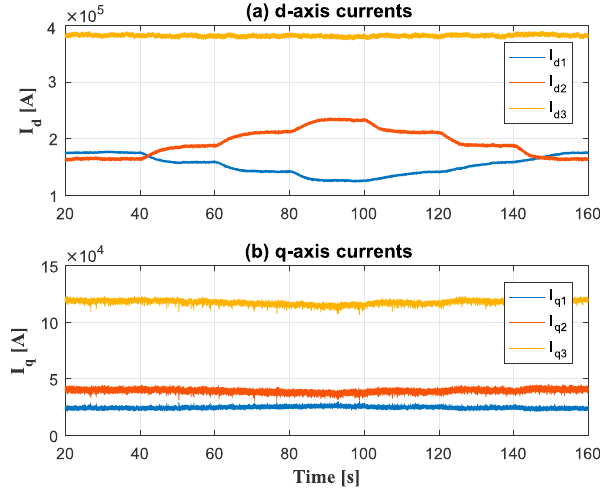
Figure 12. ( a ) d-axis and ( b ) q-axis inverter currents.